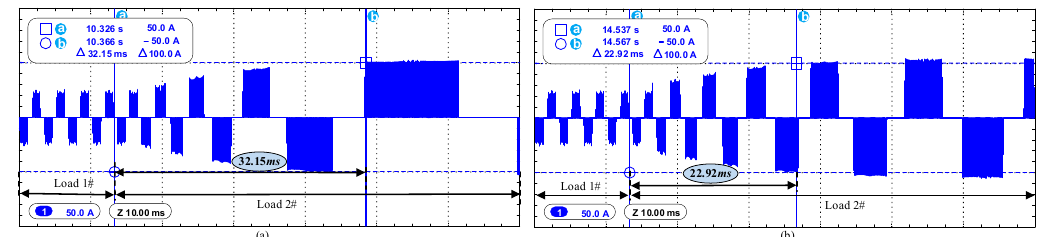
Figure 13. Part of the phase-current waveforms during abrupt load torque change from 1 to 3 N.m. ( a ) Normal state; ( b ) adjustment state ( K 2 = 1 ) .